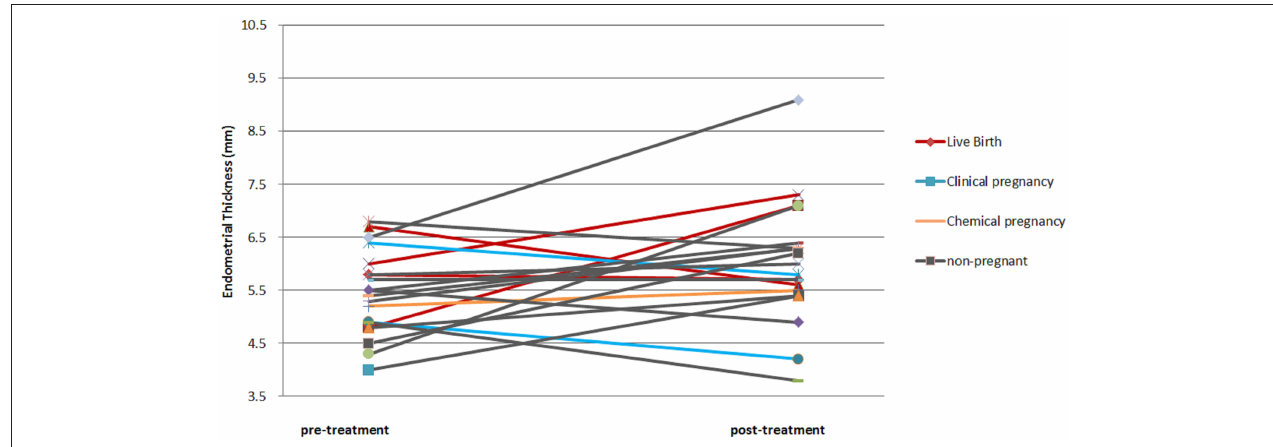
FIGURE 1 | Pre- and post- endometrial thickness of each patient. The color of the line indicates the obstetric result of the patient.